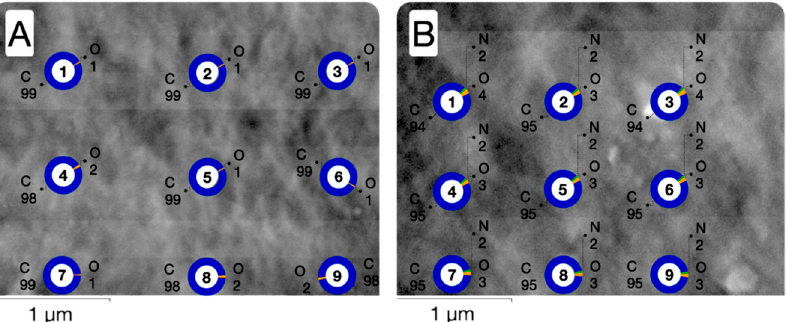
Figure 6. The SEM and EDS analyses (in weight %) of the two micron surface layers of the initial ( A ) and treated ( B ) LDPE-substrates. C—carbon; N—nitrogen;